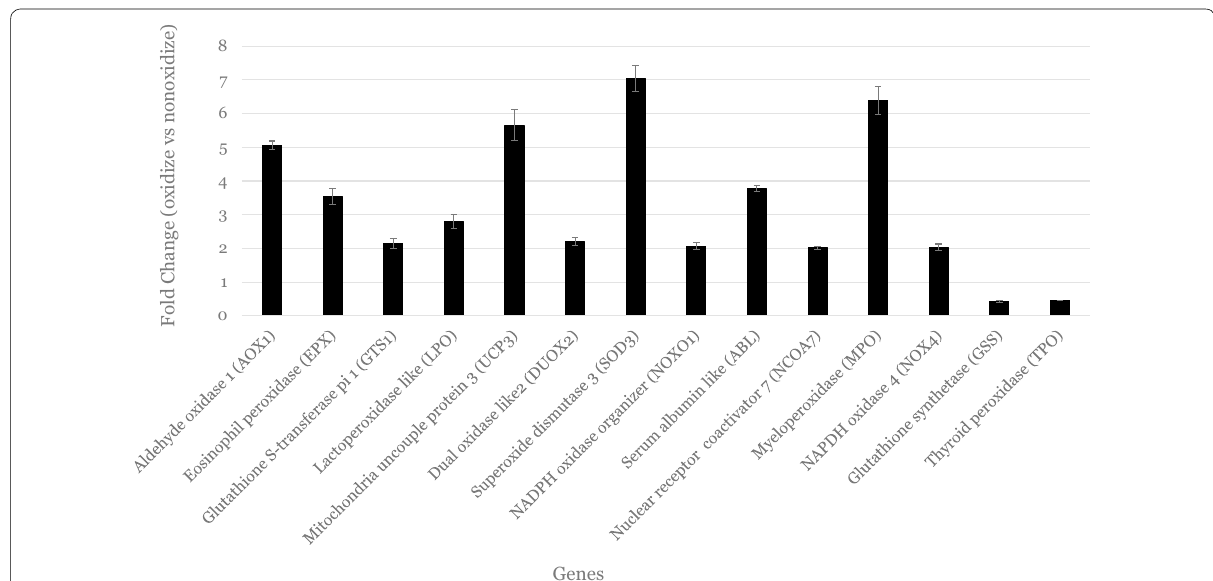
Fig. 6 Gene transcription study was performed using RT 2 Profiler PCR array. A total of 84 genes were analyzed of which 12 were highly transcribed under the growth conditions, where the target molecule was oxidized. Transcription ranged from 2.02 to 7.04-fold over the oxidative gene control, bioreactor 8, which demonstrated no oxidation of the rFab molecule. Under similar growth conditions two oxidative protective genes glutathione synthetase and thyroid peroxidase were down regulated; transcription levels 0.426 and 0.46-fold less than